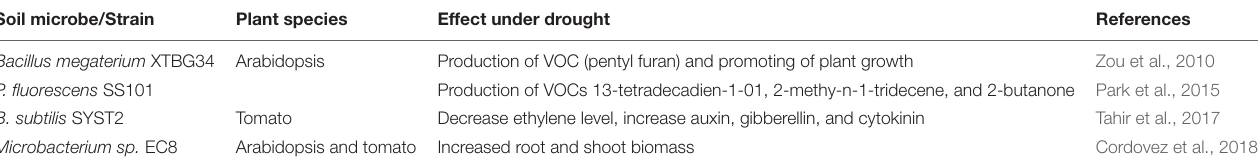
TABLE 7 | Improvement in phytohormone/enzyme production by PGPR under drought